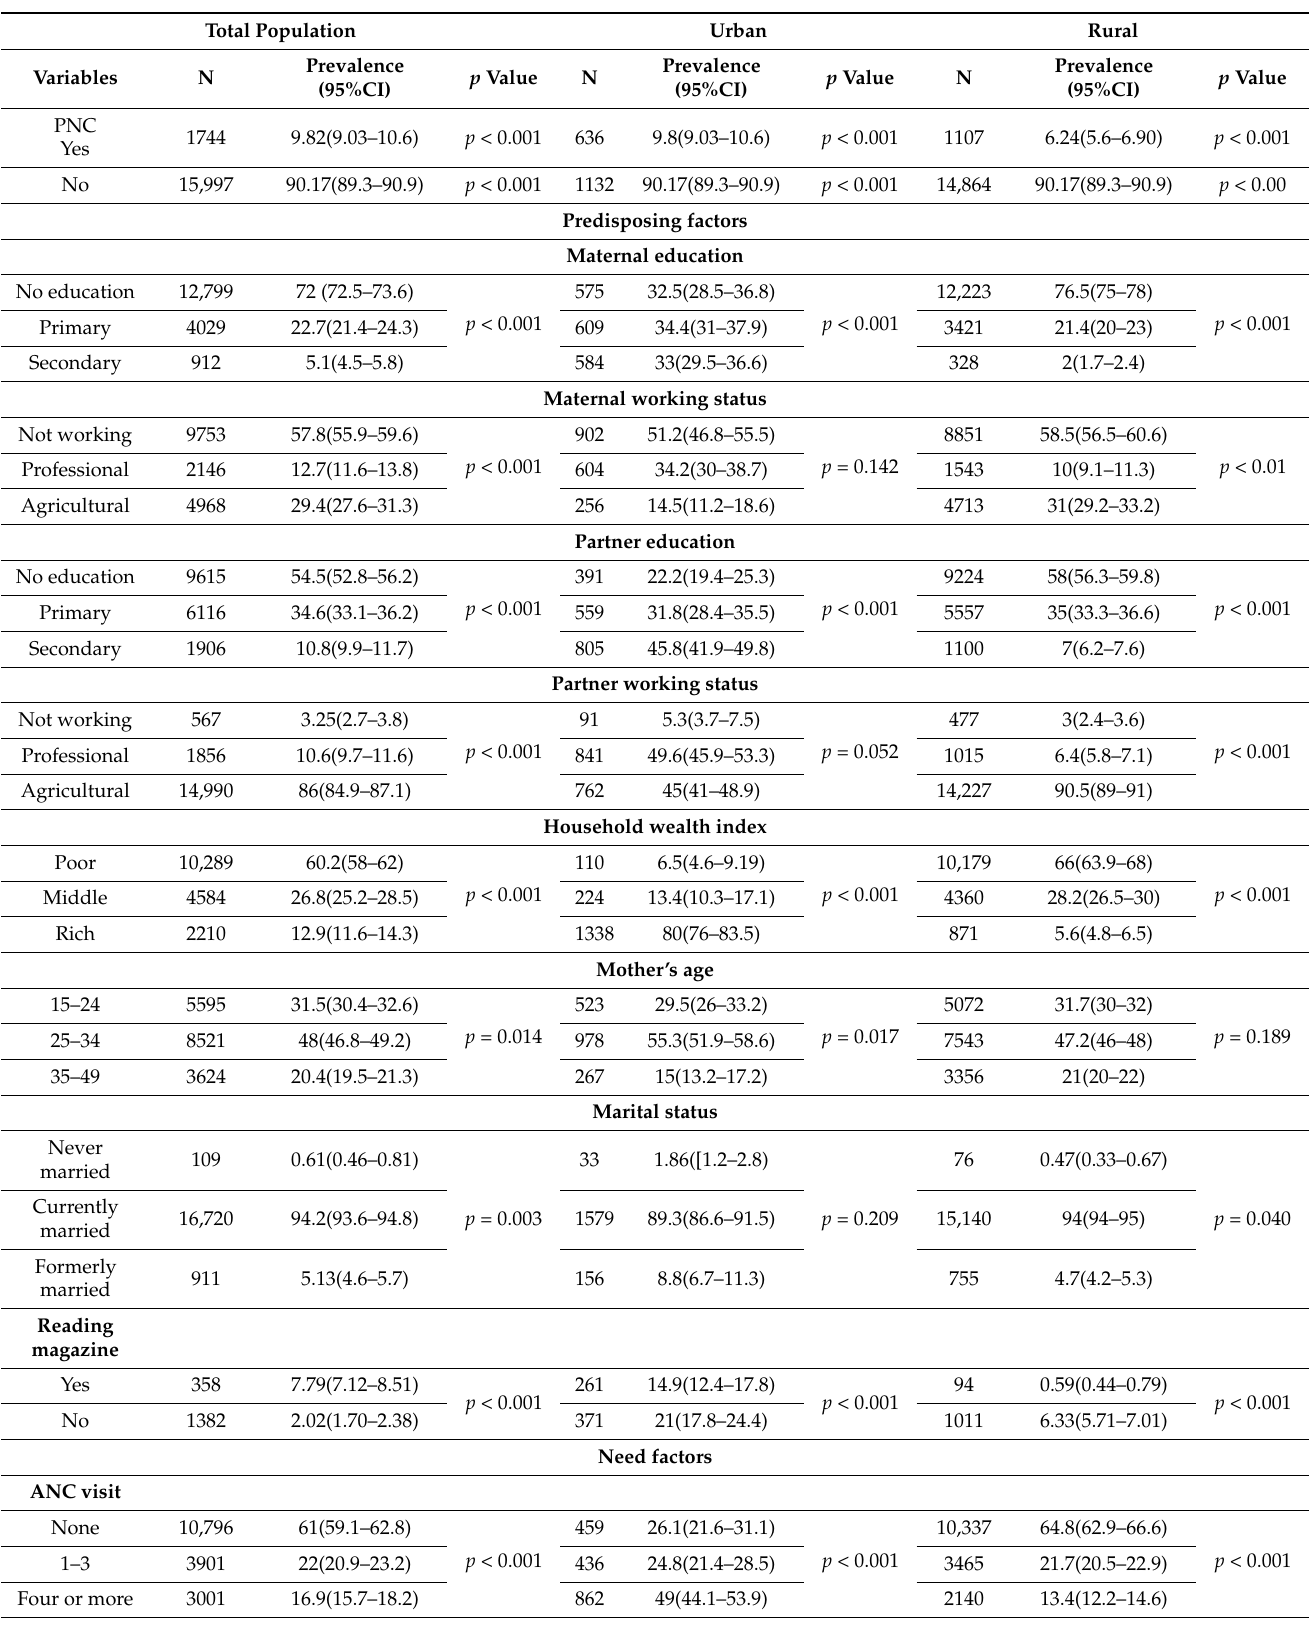
Table 1. Prevalence of postnatal care by study factors in Ethiopia (Ethiopian Demographic and Health Survey (EDHS))